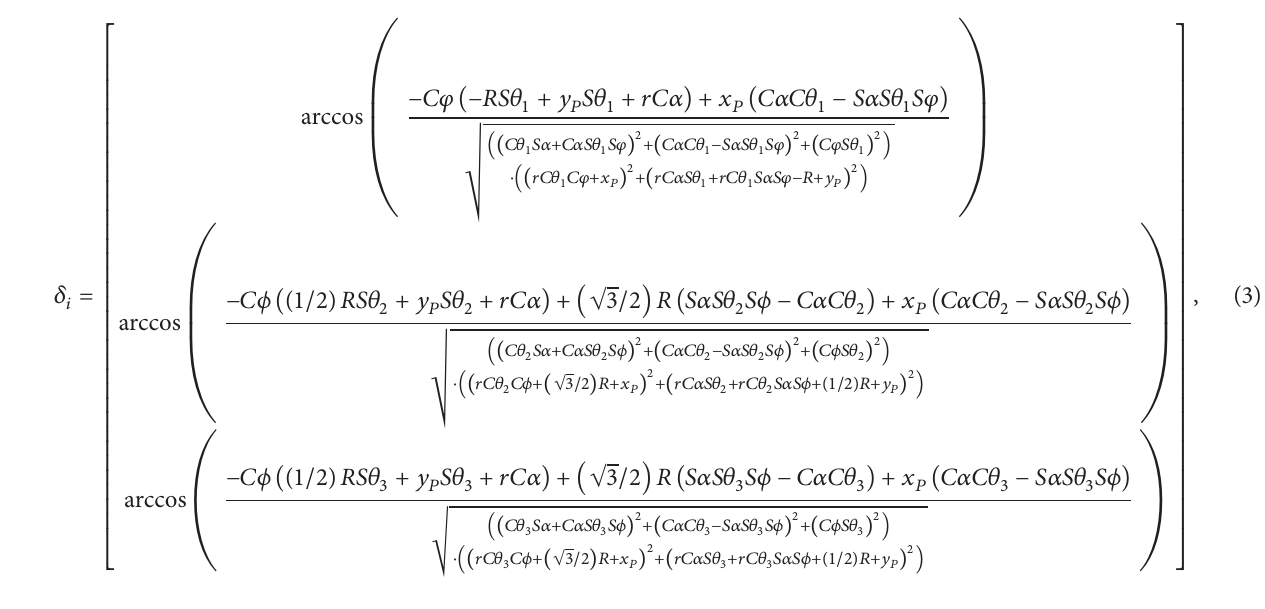
To find the angular 𝛿 𝑖 , by which the 𝑖 th piezoelectric actuator has to move to overcome the deviations of the moving platform, the analytic geometry analyses were used. It was necessary to appoint two vectors, P 𝑛 𝑏 normal to the main axis of symmetry of the actuator’s shaft and P 𝜏 tangent to the platform at the point of joining with the right arm of the micromanipulator, and then determine the angle